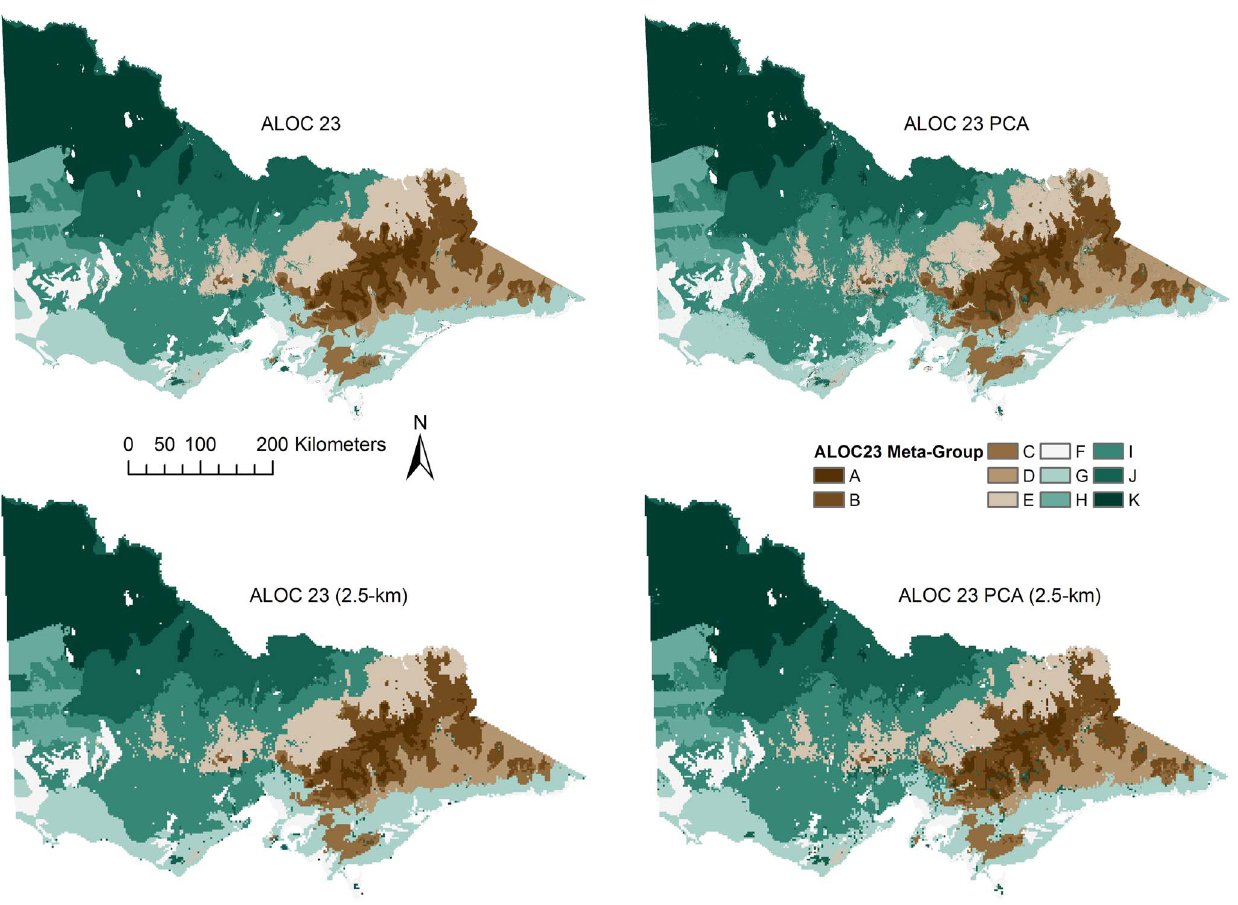
Figure 8. Results of the ALOC 23 (30 m) meta-group allocations. Top row - ALOC 23 and ALOC 23 PCA; Bottom row - ALOC 23 and ALOC 23 PCA resampled to 2.5 km. Colours represent each of the hierarchical meta-groups as defined by SIMPROF. Similar colours and group letters indicate a closer relationship than those further apart.